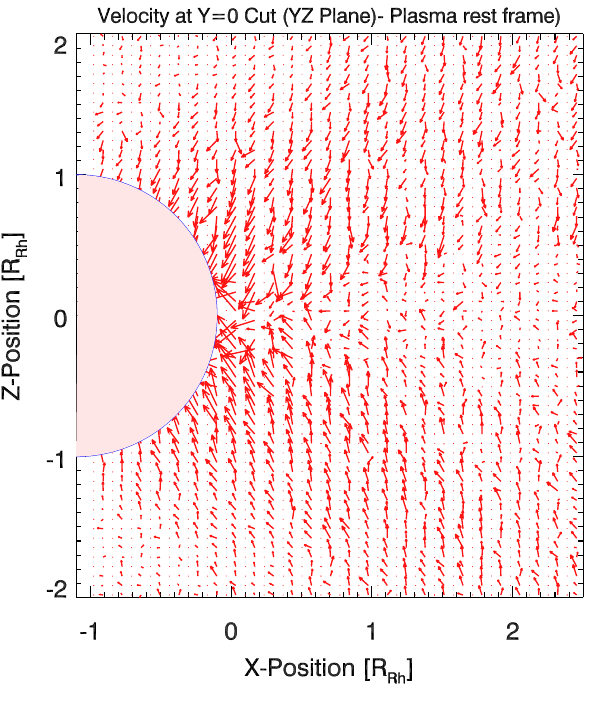
Fig. 9. Velocity and electric field in the plasma rest frame, projected on the equatorial plane (top and bottom panel, respectively). Fig. 8. Perturbations of v x and v z in an yz-cut just behind Rhea, in the plasma rest frame. Plasma expands along the magnetic field lines, symmetrically with respect to the z =0 line.